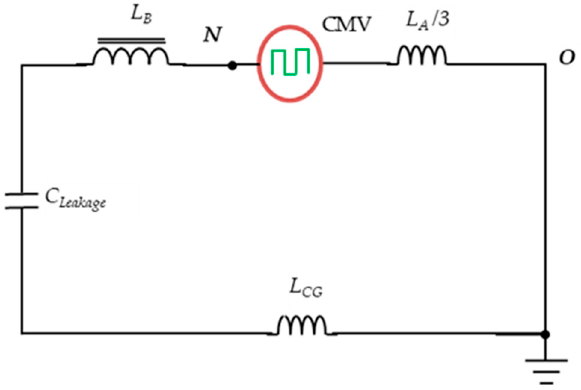
Figure 3. The CMV model of the H8 transformerless inverter.